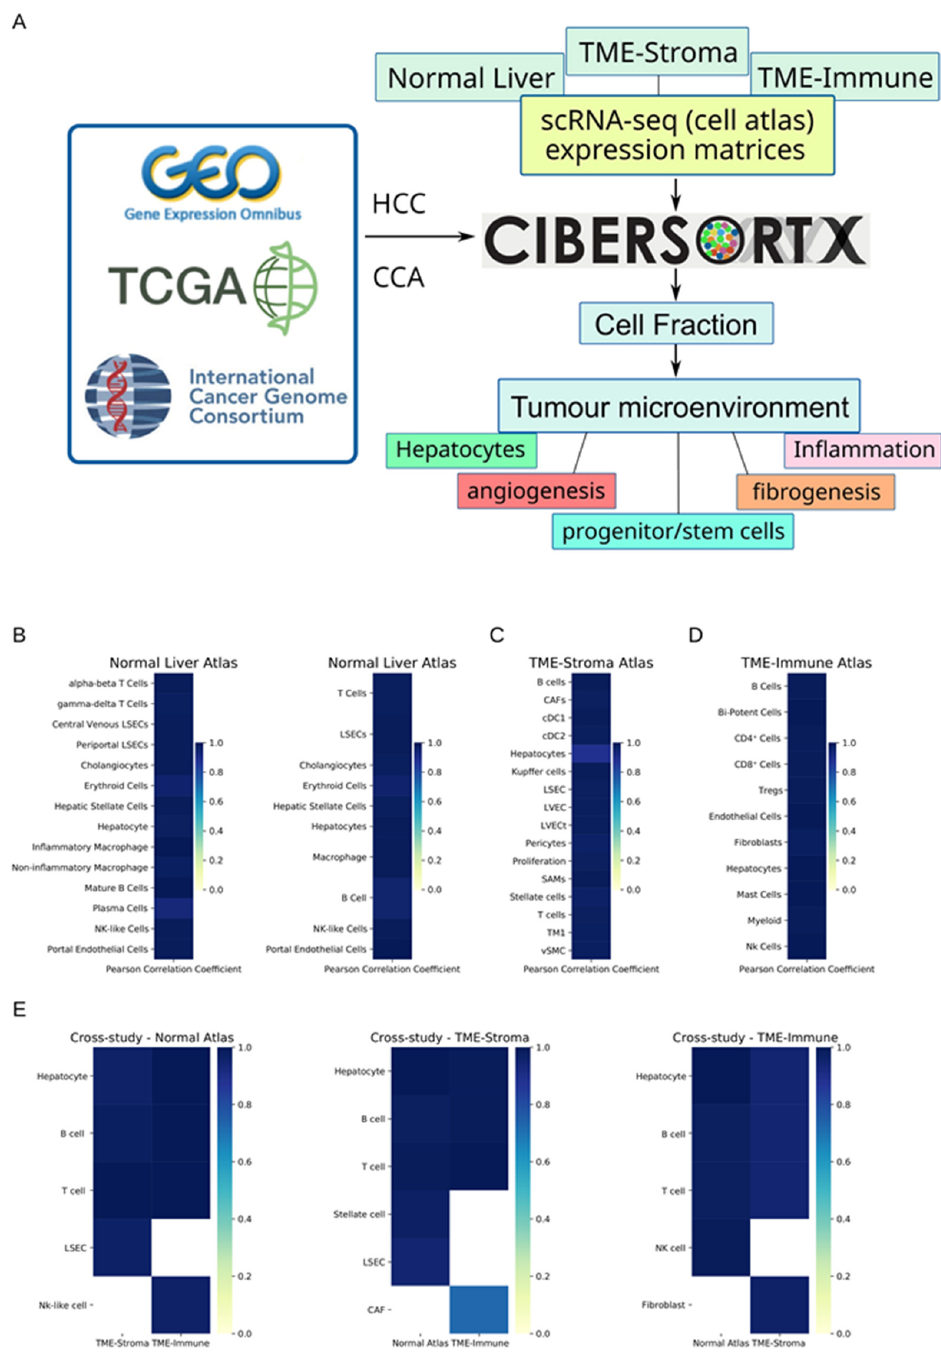
Figure 1. Study workflow and in silico validation of Cibersortx. ( A ) A general workflow of deciphering tumour microenvironment. Cibersortx estimates the cell fraction with scRNA-seq atlas and bulk RNA-seq/microarray data. Three expression matrices of scRNA-seq study were used as reference atlases. Through estimation of the fractions of more 20 cell types/subtypes, biological events could be inferred. ( B – D ) Performances of Cibersortx deconvolution in intra-study validation experiments. ( E ) Performances of Cibersortx deconvolution in cross-study validation experiments. The title of each panel indicates which reference atlas was used in the deconvolution, two ticks on the bottom indicate which dataset was used to generate the pseudo-bulk samples.